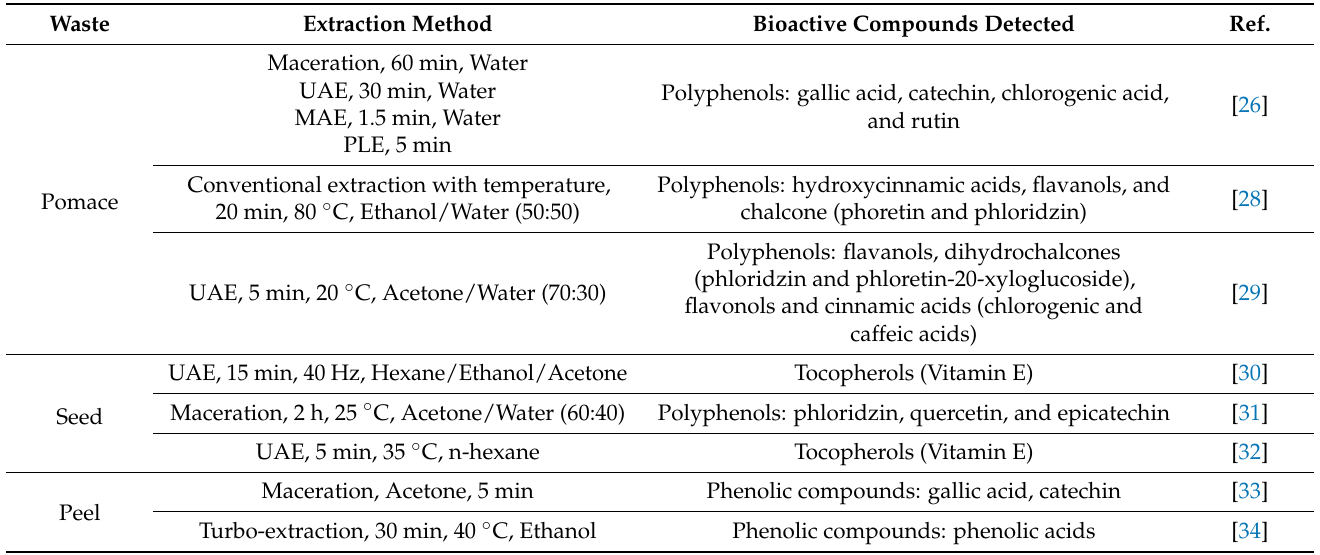
Table 3. Summary of studies found in literature on the extraction of bioactive compounds from apple